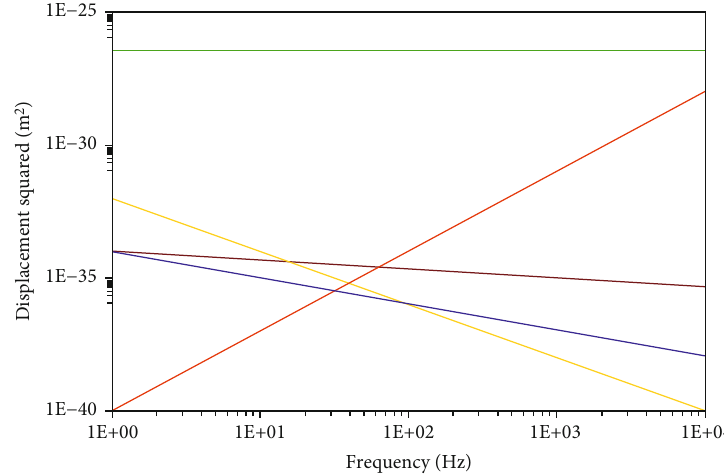
Figure 8: In this fi gure the amplitude of the dependence of noise, limits and signal can be seen. The green line is the displacement signal in the detector, the red line is the detector sensitivity, the purple line shows the back-action and the electronic series noise chosen to be equal, the yellow line displays the thermal noise and the blue line shows the quantum limit. Source: From the